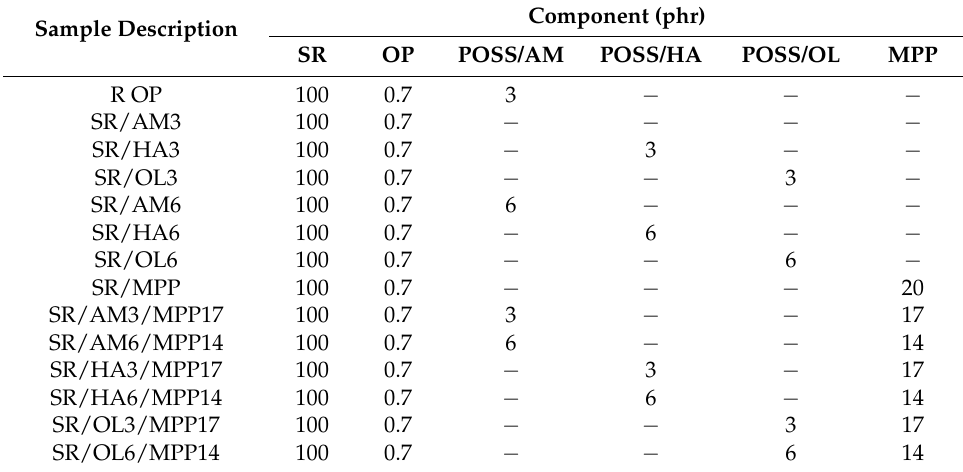
Table 2. Composition of the silicone (SR) rubber-based